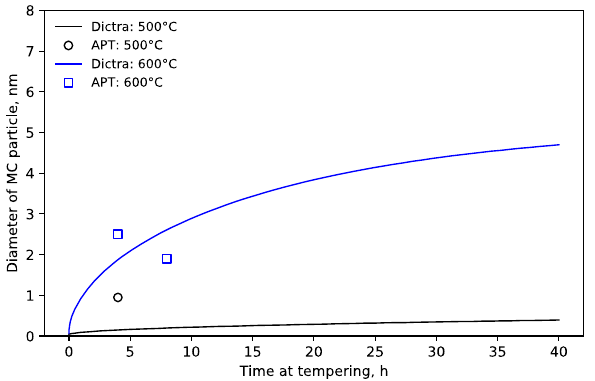
Figure 12. Simulated size of MC carbides according to Dictra, and a rough estimate from APT analysis. The size denotes the diameter of the elongated cylindrical particles at isothermal holding at 600 °C.